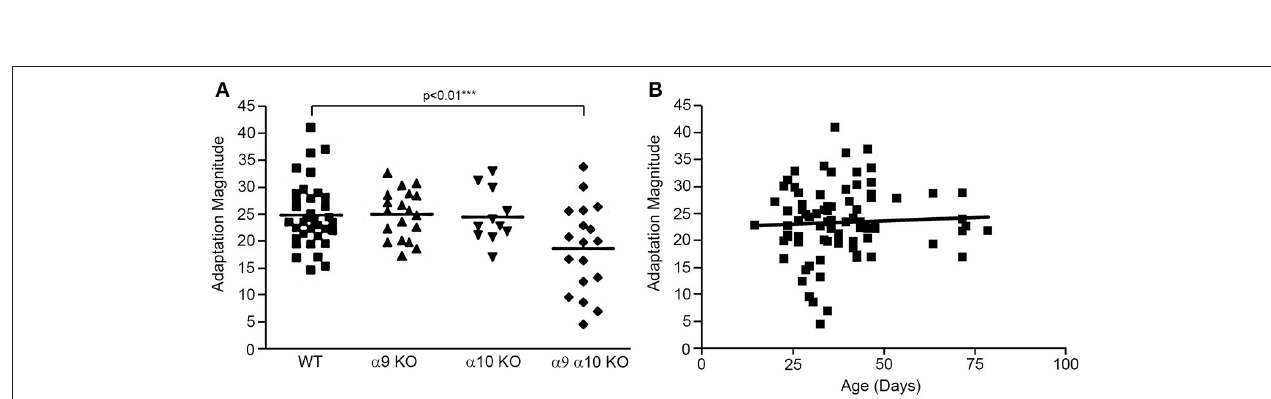
FIGURE 11 | (A) Efferent mediated adaptation of DPOAE. Although there was a significant overall group effect [ F (3, 81) = 4.33; p < 0.01], there was not a significant difference between wild type and either α 9 or α 10 knockouts. Only the double ( α 9 α 10) knockout group had significantly lower adaptation scores ( p < 0.01). (B) The animals were tested as a young age (26–82 days) to avoid effects attributable to the ahl (age-related hearing loss) locus carried by C57BL/6J mice. There was not a correlation between adaptation scores and age in this study ( r = 0.051).